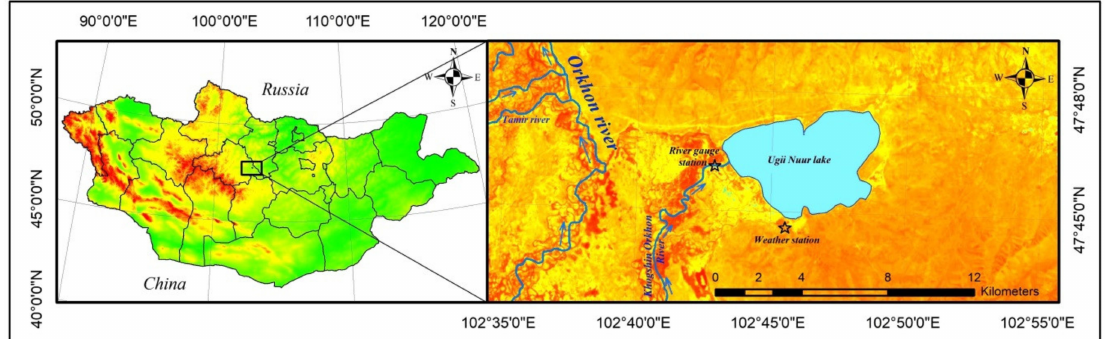
Figure 2. The geographical location of the Ugii Nuur